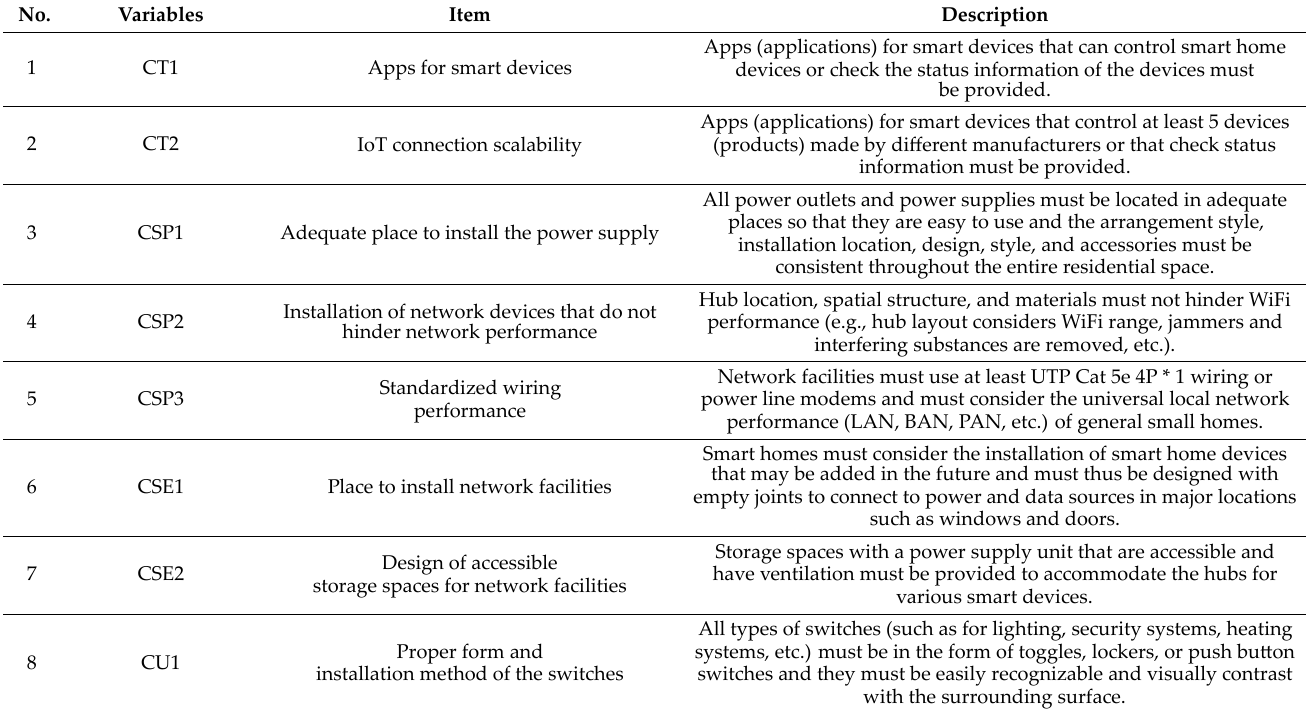
Table 2. Evaluation